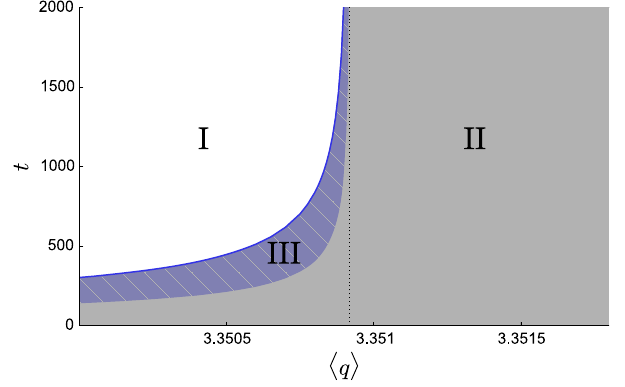
FIG. 9. Phase diagram for the k -core pruning process in the h q i - t plane. The vertical line represents the critical point h q i ¼ h q i c ( k ¼ 3 for this figure). In region II at h q i > h q i c , the pruning process reduces the network to the giant k -core as time approaches infinity. Only finite corona clusters are present in region II. A giant corona cluster is present in region III. The mean branching is 1 on the border between regions II and III. The mean branching is below 1 in region II and larger than 1 in region III. The network collapses at times on the upper boundary of region III, so there is no network in region